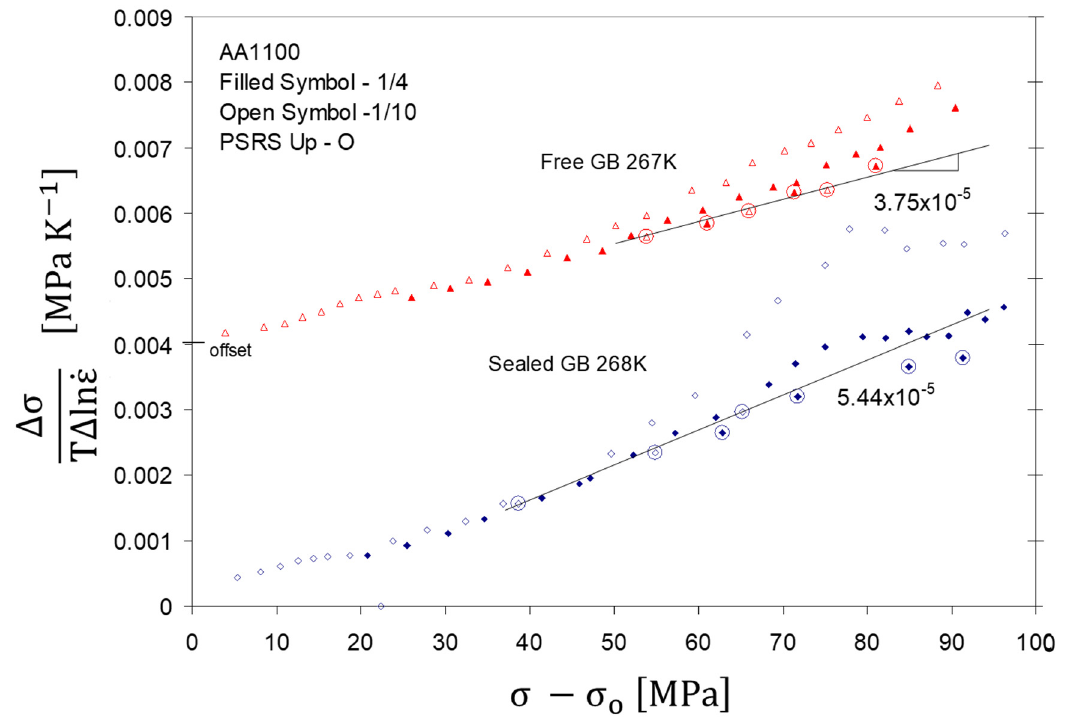
Figure 8. Comparison of Haasen plots for free-GB and sealed-GB specimens tested at 267 K. The slopes for the up-change are denoted. The hump observed at 195 K for the free-GB case in the initial strain range is much reduced. For sealed-GB down-change plot at high strains, the slope abruptly decreases to about 1.0 × 10 − 5 K − 1 , suggesting nano-void formation.